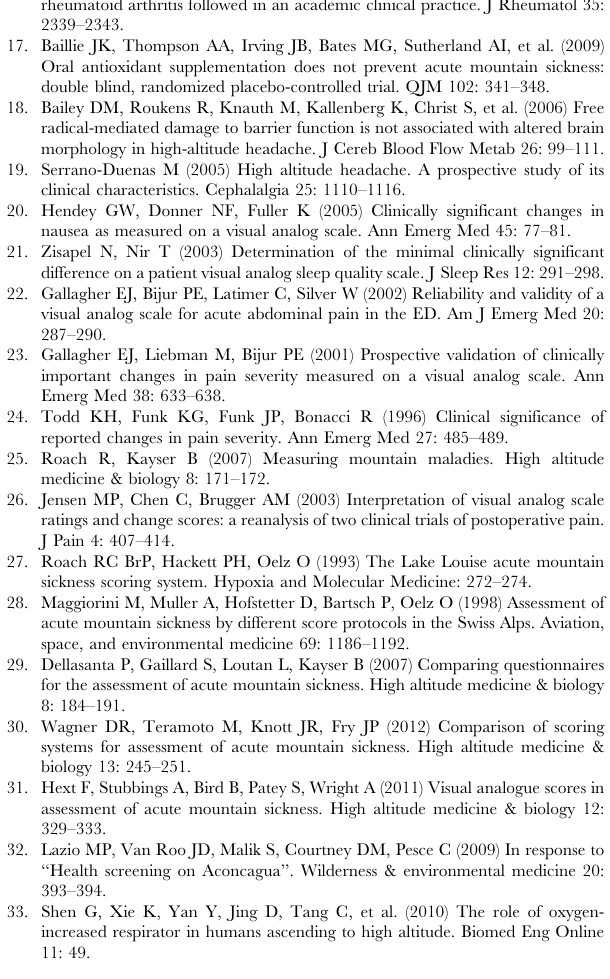
Table S1 Volunteer characteristics. Table S2 The ascent and descent phases. Table S3 VAS score at different